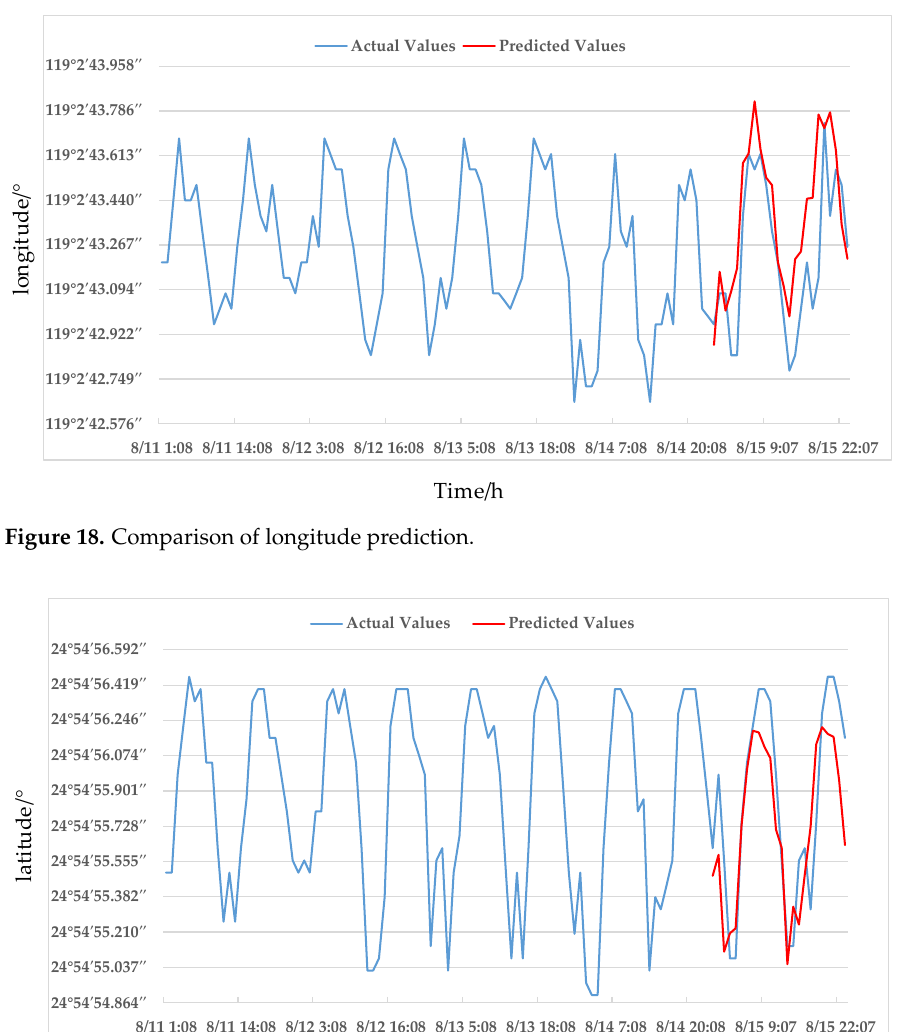
Figure 19. Comparison of latitude prediction.